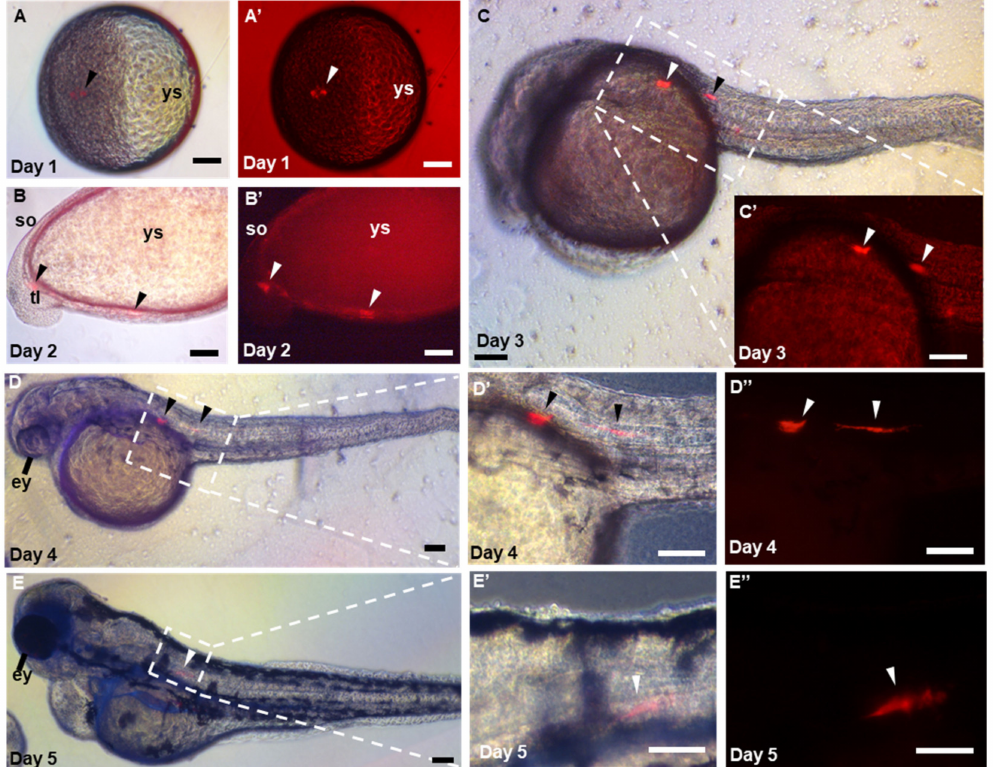
Figure 5. Pluripotency of ObSSCs in vivo. ( A – E ) Different stages of embryo, in which the chimeras were observed by microscopy at 1 to 5 days post-fertilization. ( A – D , D (cid:48) , E , E (cid:48) ) Merge of bright and fluorescent fields. ( A (cid:48) – C (cid:48) , D” , E” ) Red fluorescent micrograph. ys, yolk sac; ey, eye; so; somite; tl; tail; ht; heart. (Scale bars, 100 µ